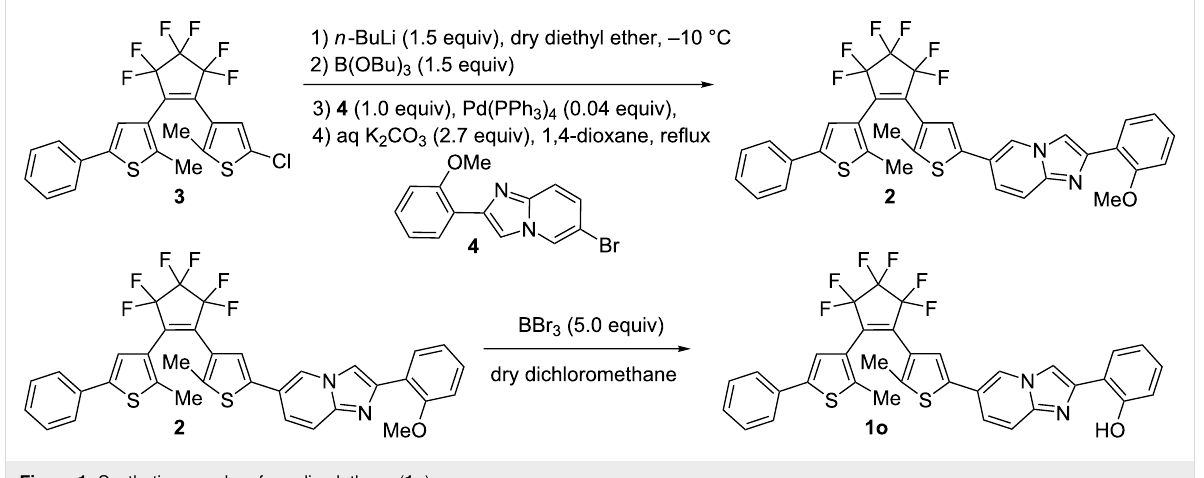
Figure 1: Synthetic procedure for a diarylethene ( 1o